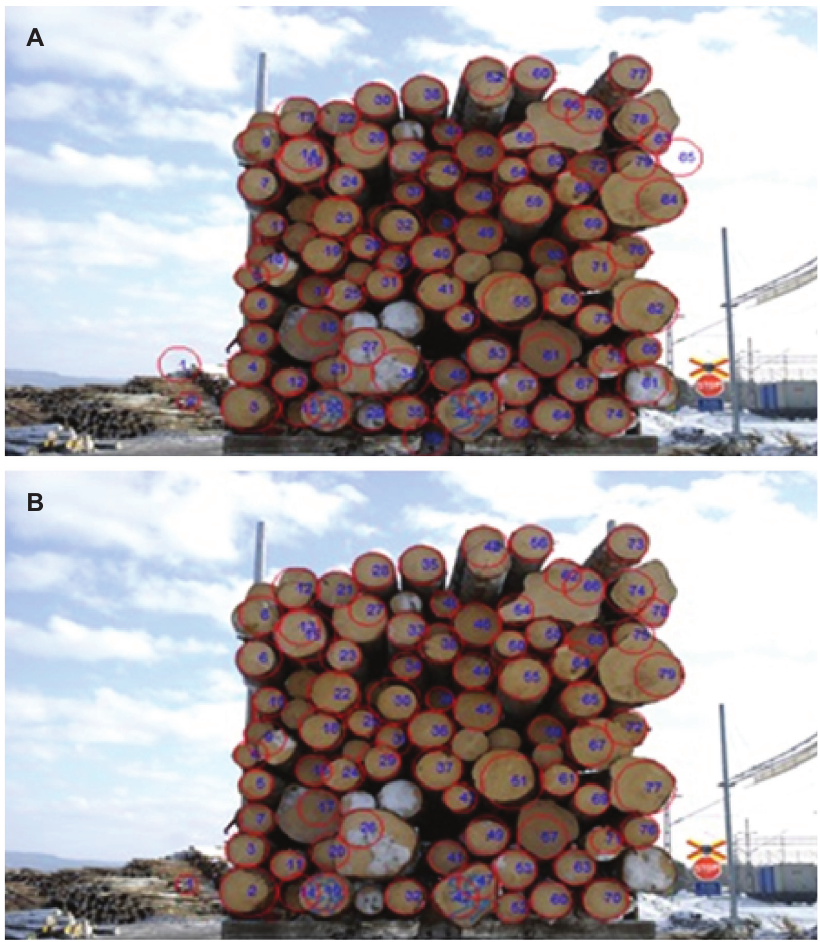
Figure 3. Image Where Log Detection Accuracy is Between 80% and